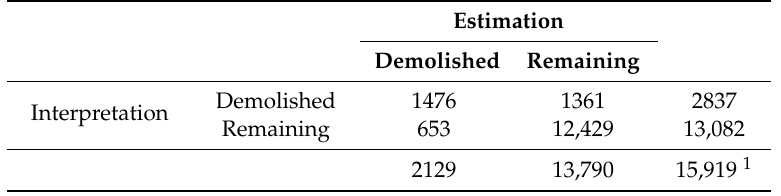
Table 7. Confusion matrix by the indicator and threshold of 0.3 for 1 January 2017 image.